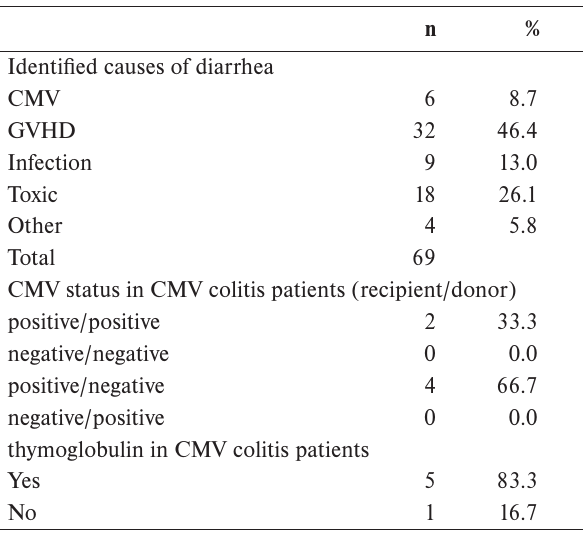
Table 2. Causative etiology of diarrhoea and demographic data in CMV colitis